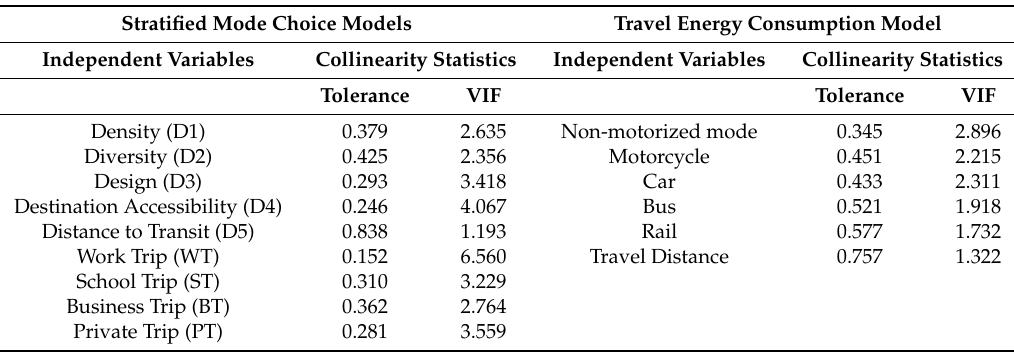
Table 7. Multicollinearity